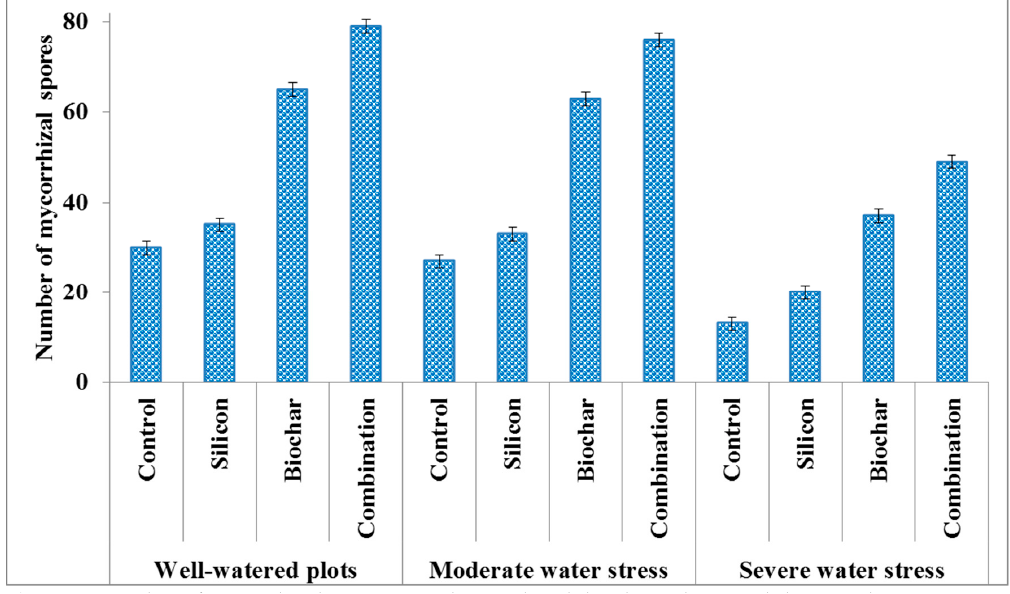
Figure 3. Number of mycorrhizal spores in soil treated with biochar, silicon and their combination under different water deficit stress treatments. Bars = Standard error of means (S.E.M.).